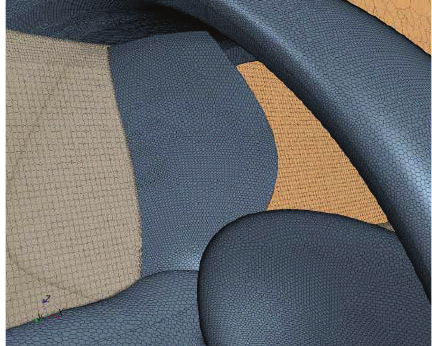
Figure 5: Polyhedral mesh arrangements for the ducted propeller— open water